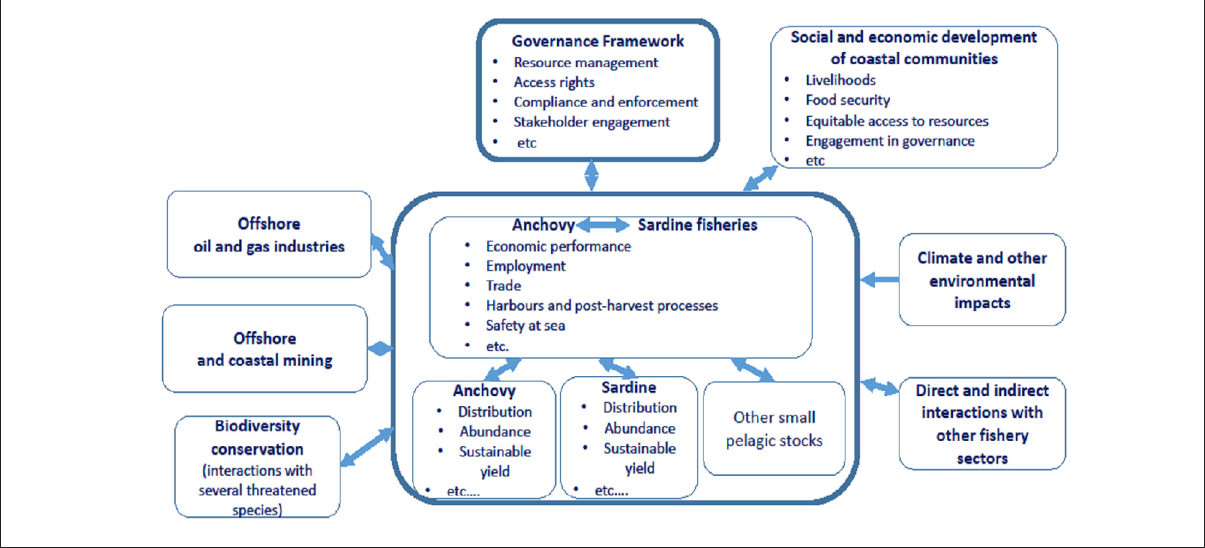
Figure 1: Simplified representation of an example of an integrated social-ecological system that needs to be managed as such: the South African fishery for small pelagic species. The boxes outlined in bold show the components of the core system and external drivers and stakeholders are shown outside the bold